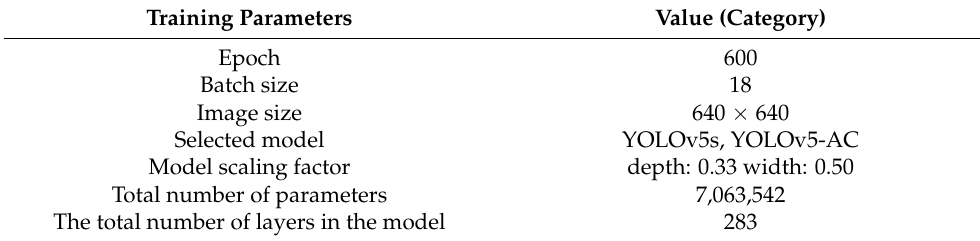
Table 3. Training parameters.